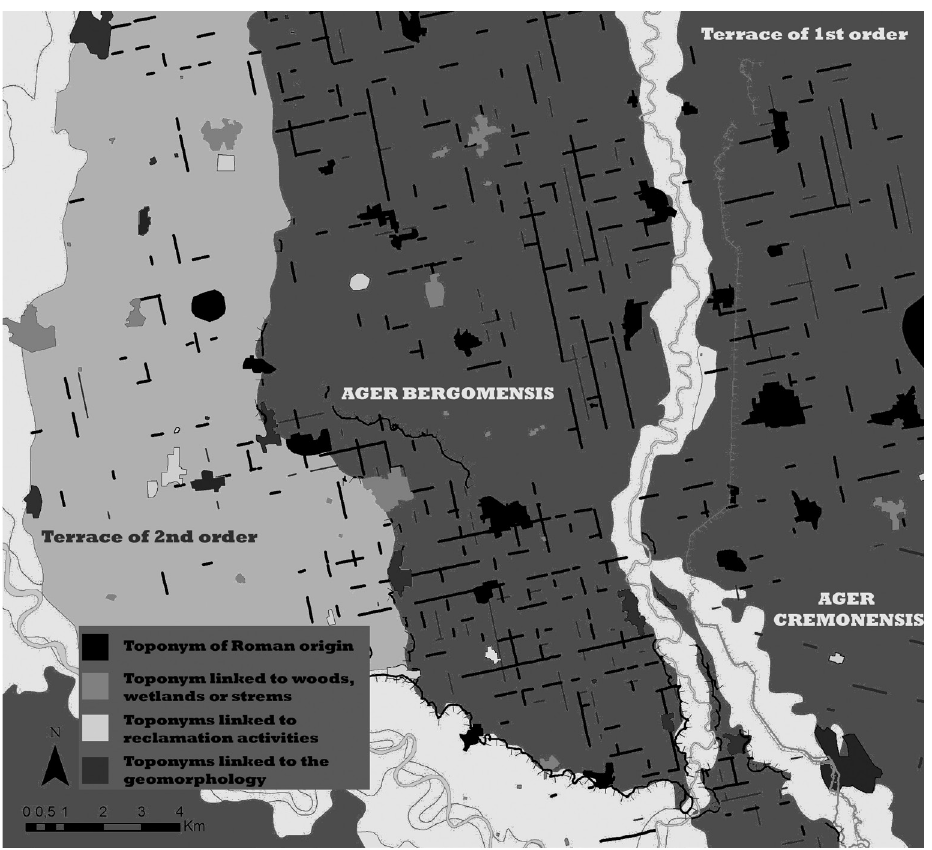
Figure 5: Distribution of toponyms between Adda river and Serio